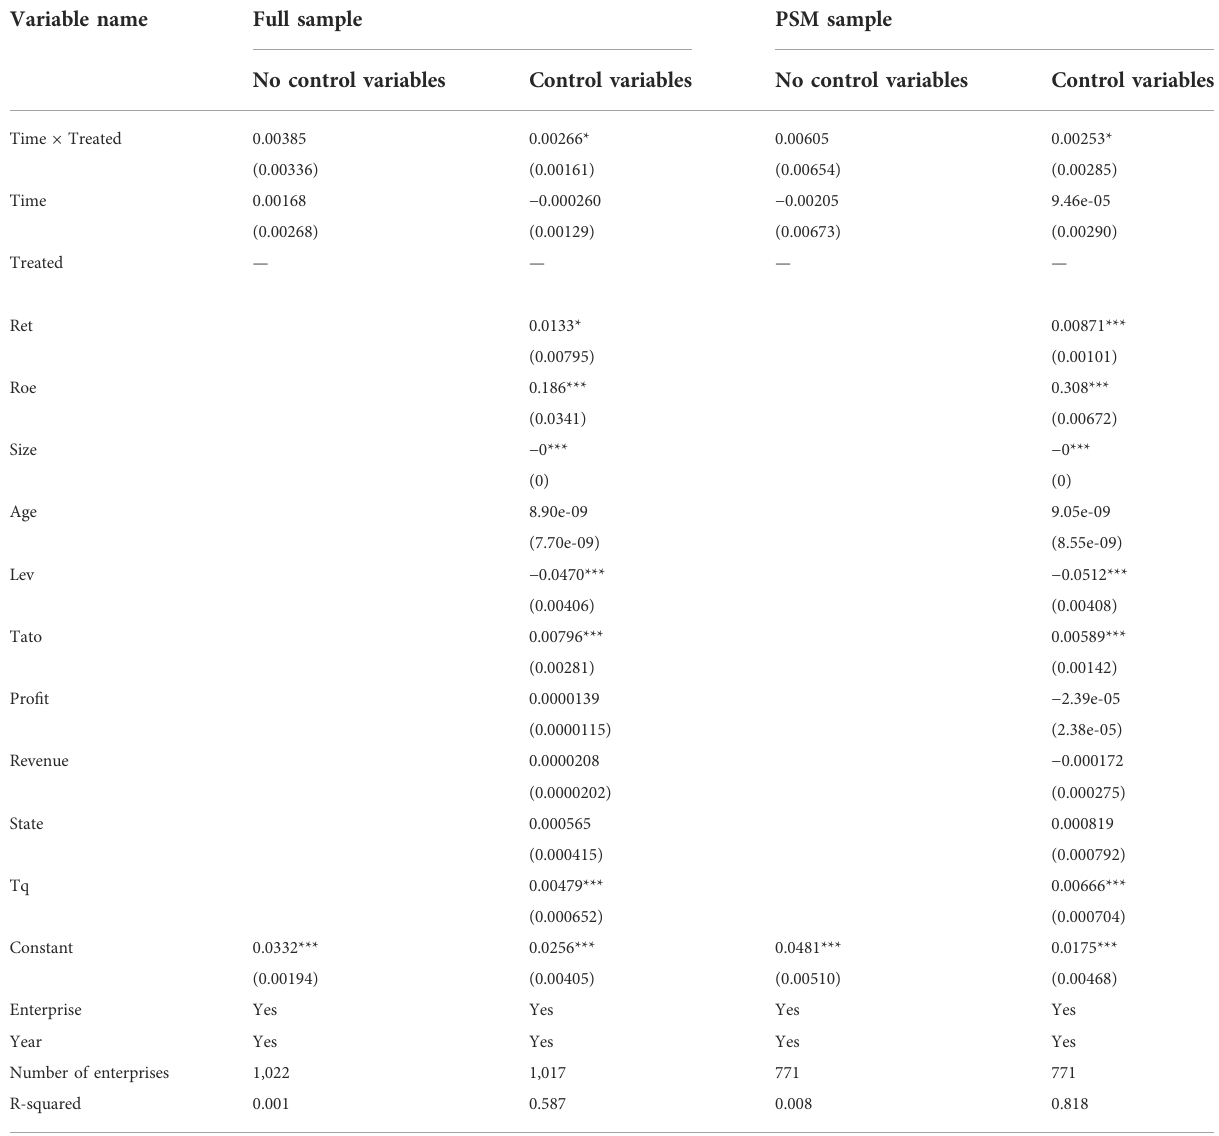
TABLE 6 Regression results after replacing control